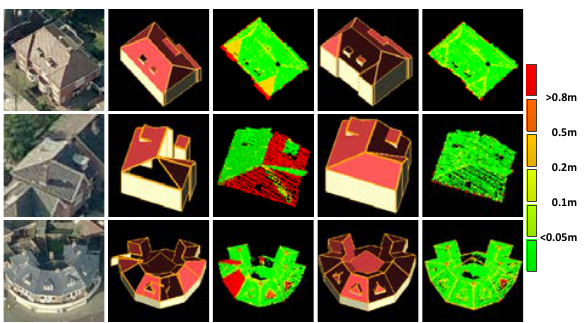
Figure 9: Model quality before and after correction in the Enschede dataset. Column 1: building image; column 2 and 4: building model before and after manual input; column 3 and 5: point clouds coloured by their distance to the corresponding models. The model quality is improved both in model structure and point distance to